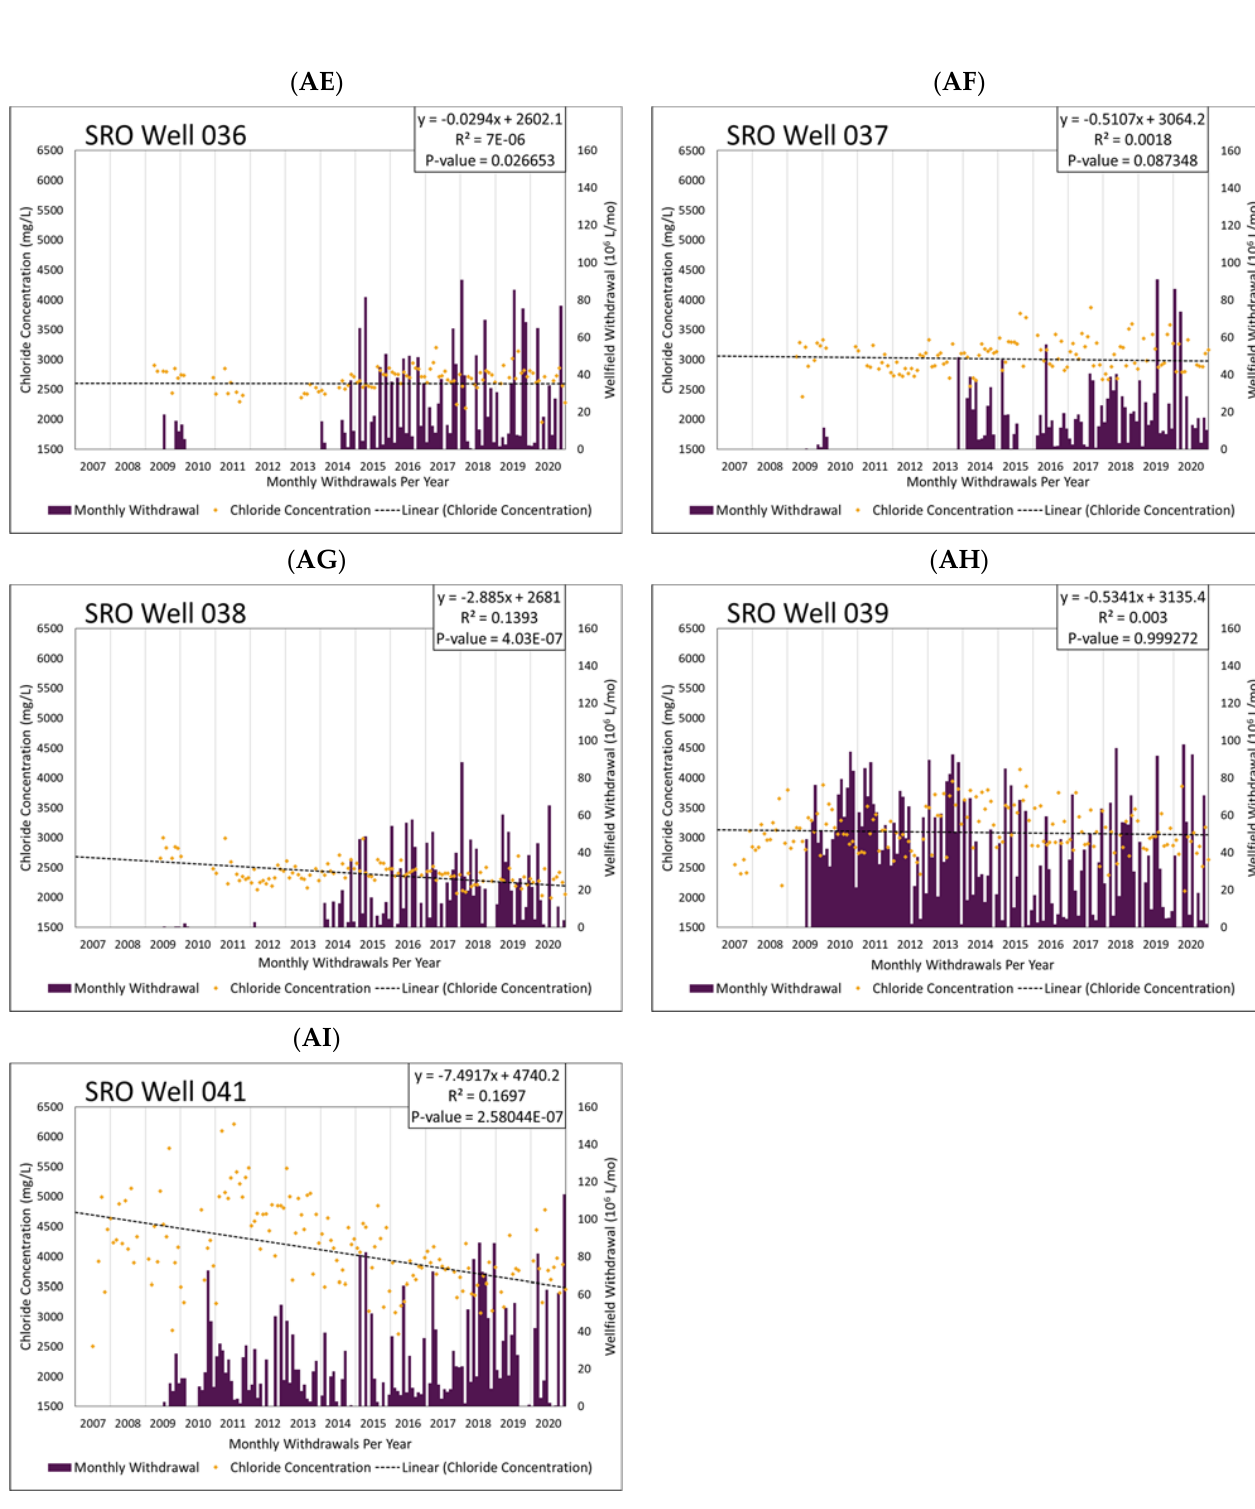
Figure 5. Plots of dissolved chloride concentration with time, monthly cumulate pumping, the calculated values of R 2 and p ‐ values and the regression equations for the trend line for Hawthorn Aquifer Zone 1 production wells.